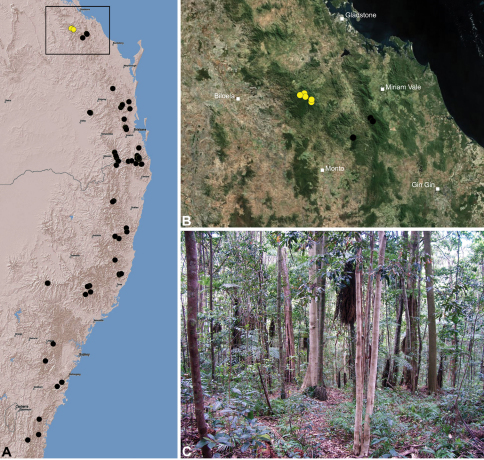
Austrarchaea alani sp. n., distribution and habitat: A, topographic map showing the known distribution of Archaeidae in south-eastern Queensland and eastern New South Wales, with collection localities for A. alani highlighted in yellow; B, satellite image showing detail of inset (A); C, subtropical rainforest near the type locality – Tablelands Road, Kroombit Tops National Park, Queensland (October 2010). Image (C) by M. Rix.